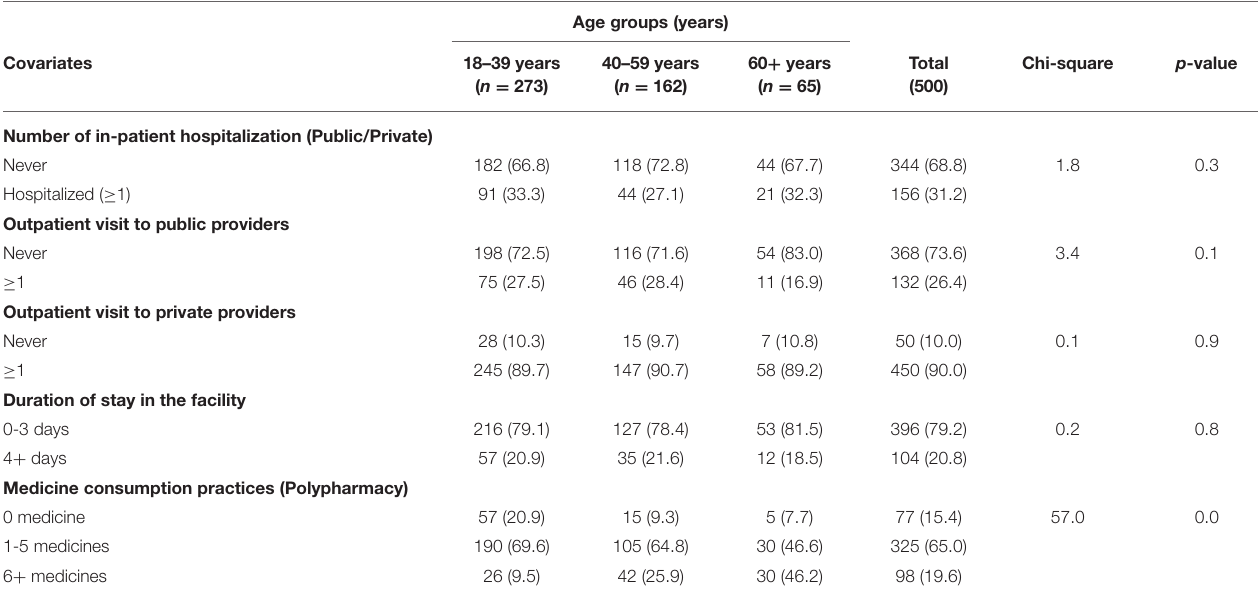
TABLE 4 | Pattern of healthcare utilization among the respondents by